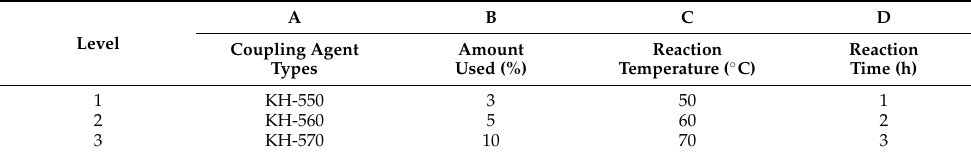
Table 2. L 9 (3 4 ) orthogonal test factor level table. Level